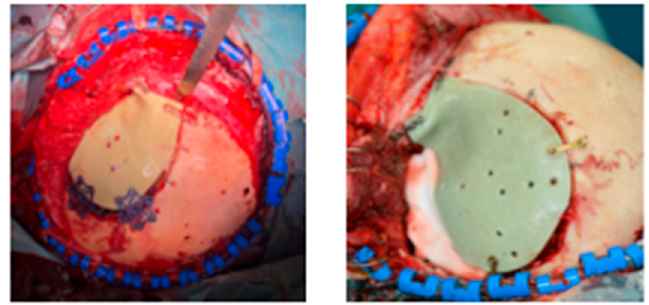
Figure 4. Cranioplasty in PMMA with titanium fixation plates and screws.